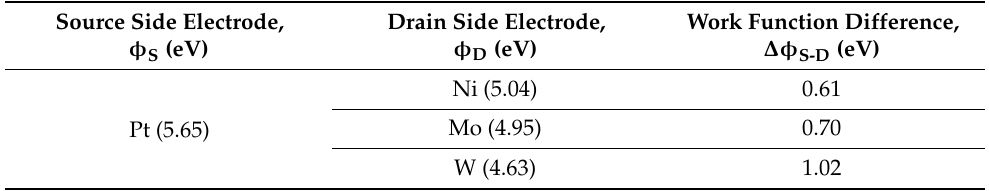
Table 1. Work function combinations and differences considered in this